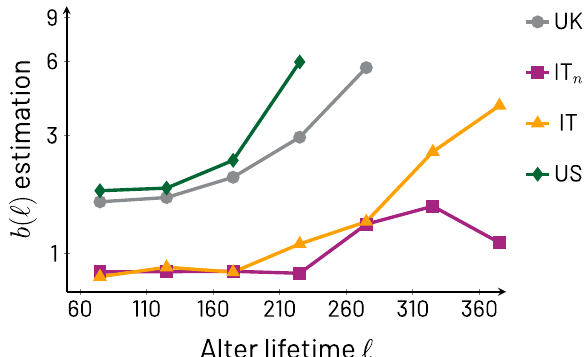
Figure 2. b (ℓ) as a function of ℓ obtained through the stable region average method (see Methods section). The vertical axis is in logarithmic scale. Clearly, b (ℓ) has an increasing trend with respect to ℓ , with minor exceptions. The UK and US cohorts display a faster increase than IT and IT n . This could be a consequence of specific differences between details of the cohort participants, such as country, age, and/or personal circumstances of the participants; for example, since the Italian cohort is focused on adult parents with pre-teenage children, these participants may have less available time to invest in phone